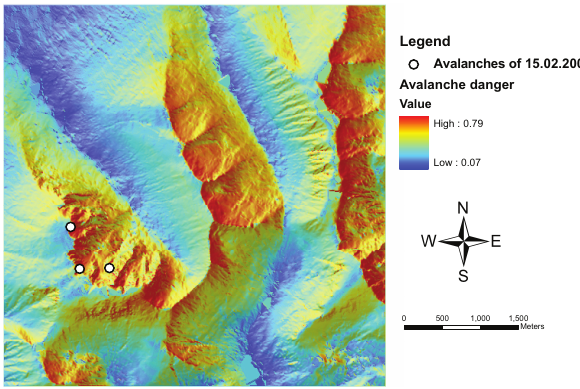
Fig. 3. Map of the avalanche danger prediction for 15 February 2007. The avalanche events observed that day are marked with white circles.